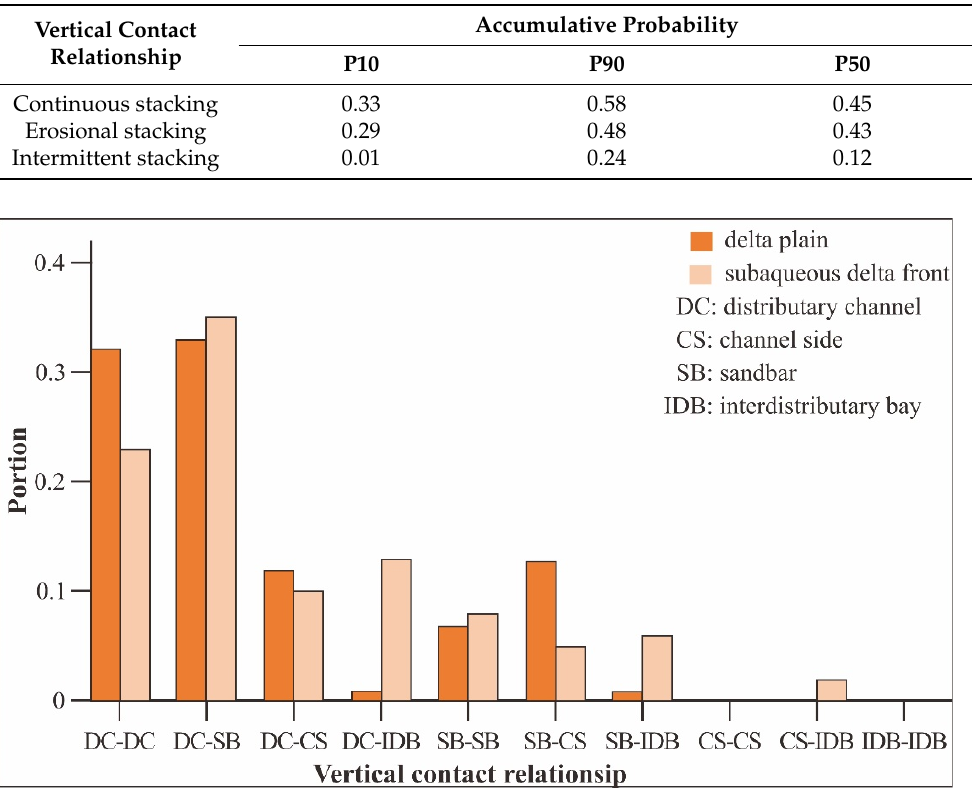
Figure 9. Vertical combinations of architectural elements and their portions. Table 6. Probability statistics of vertical contact relationships of architectural elements.